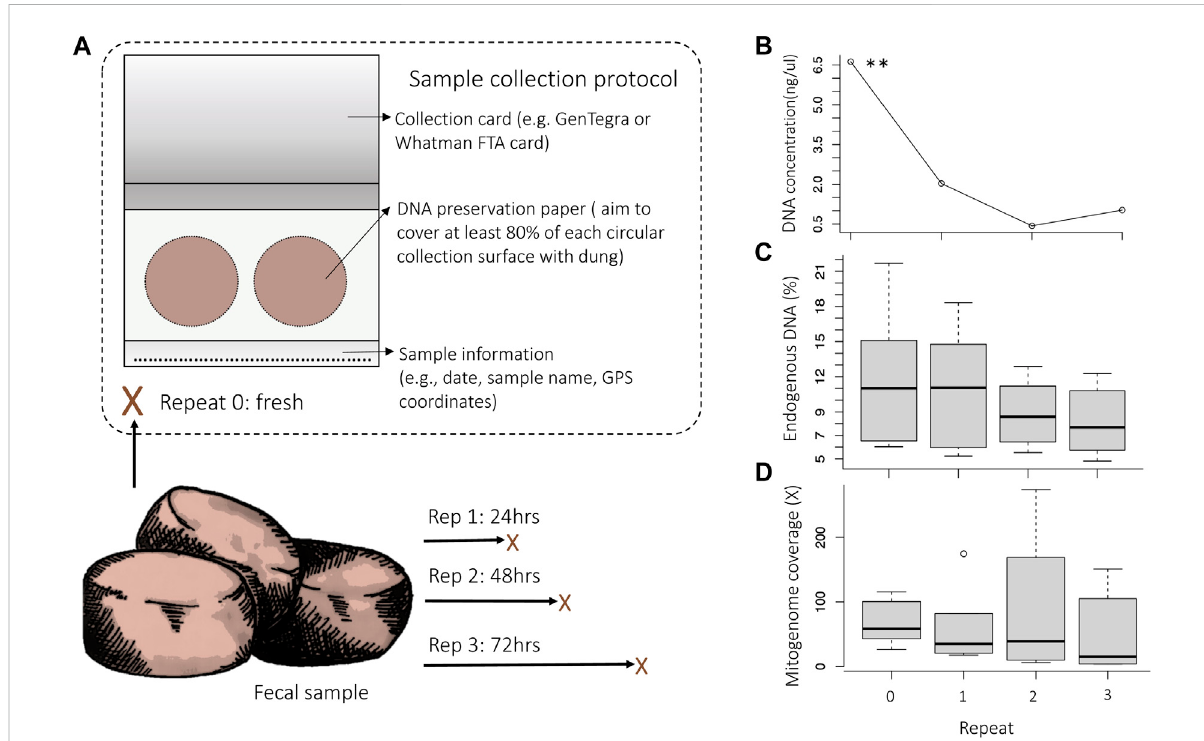
FIGURE 1 Experimental setup of replicate sampling. Assessment of the DNA concentration, endogenous DNA content (% reads mapping to the nuclear reference genome LoxAfr4.0) and mitogenome coverage (the average X-fold number of reads mapped at any location across the mitogenome) for the comparison of repeated samples that were collected over time from the same dung bolus. (A) Repeat samples were collected from dung immediatelyafterdefecation(Rep0)andsubsequentlyat24 h(Rep1),48 h(Rep2)and72 h(Rep3)postdefecation.Eachsamplewascollected on an Ahlstrohm GenSaver 2.0 ™ card using both collection surfaces (indicated with circles). (B) There was a signi fi cant decrease in DNA concentration as time after defecation increased (rep. measure ANOVA p = .0052). The percentage of endogenous elephant DNA also decreased as time after defecation increased (C) , as did the mitogenome coverage (D)